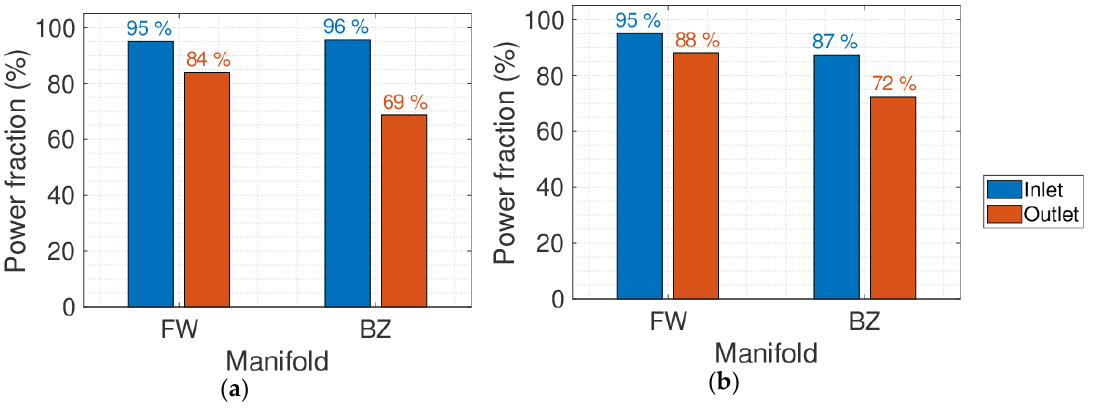
Figure 9. Power transferred through the walls interfacing manifolds at different temperature, as a fraction of the total power exchanged in the corresponding manifold: ( a ) with adiabatic wall; ( b ) with radiative heat transfer.